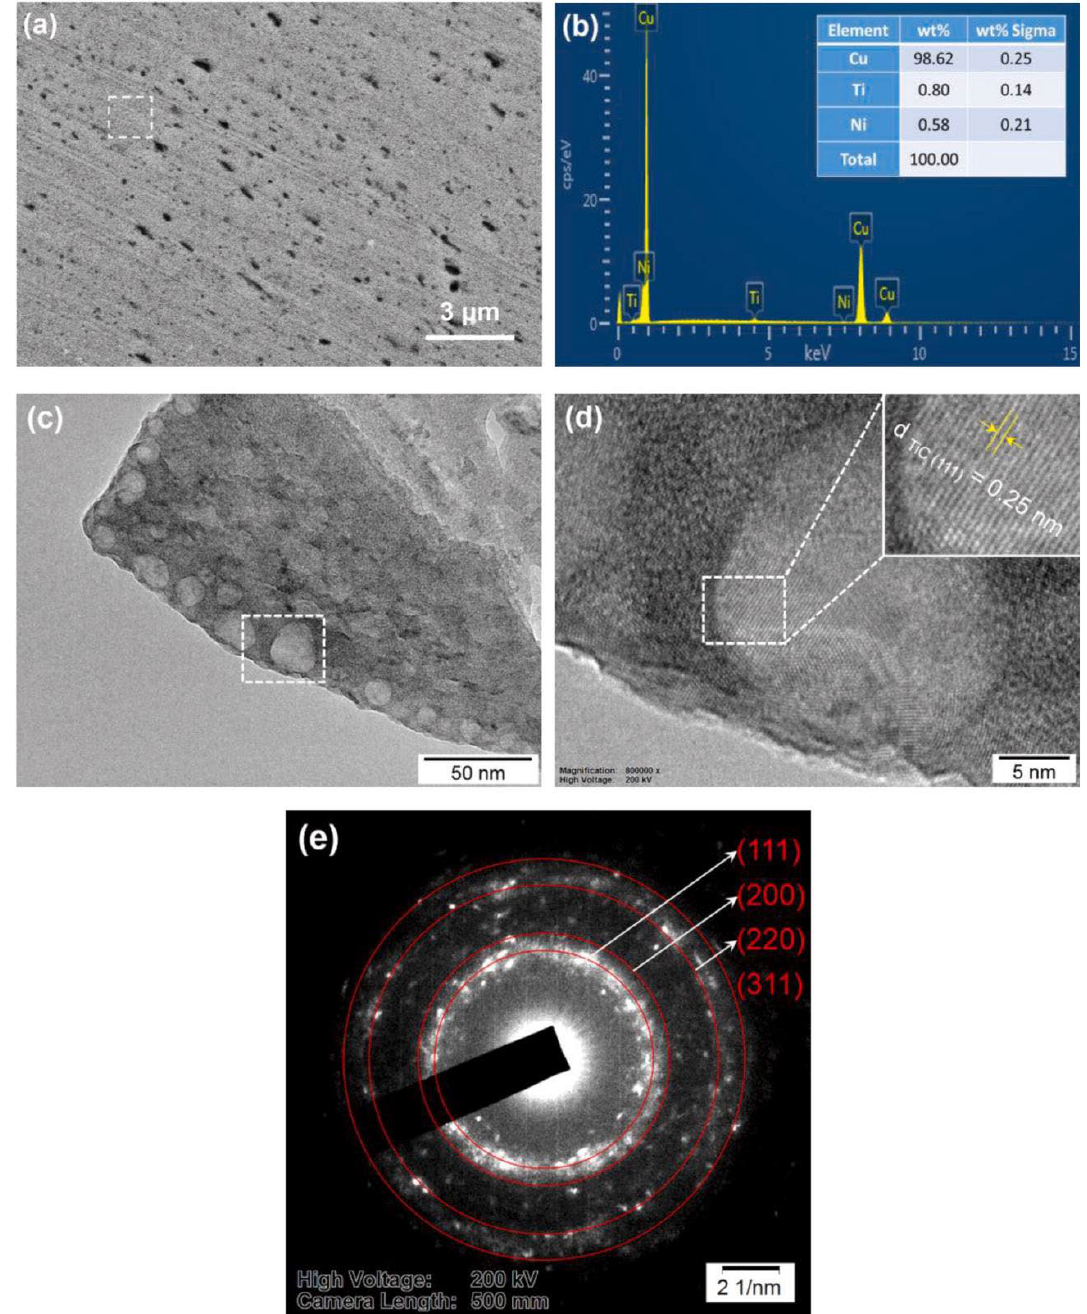
Figure 28. ( a ) The backscattered electron SEM image of the 3(Ni-MXene)/Cu-3 h, ( b ) EDS analysis of the rectangular area marked in ( a ), ( c ) typical TEM image of 3(Ni-MXene)/Cu-12 h, ( d ) the enlarged image corresponding to the rectangular area marked in ( c ), and ( e ) the SAED pattern corresponding to the area of ( c ) [75].